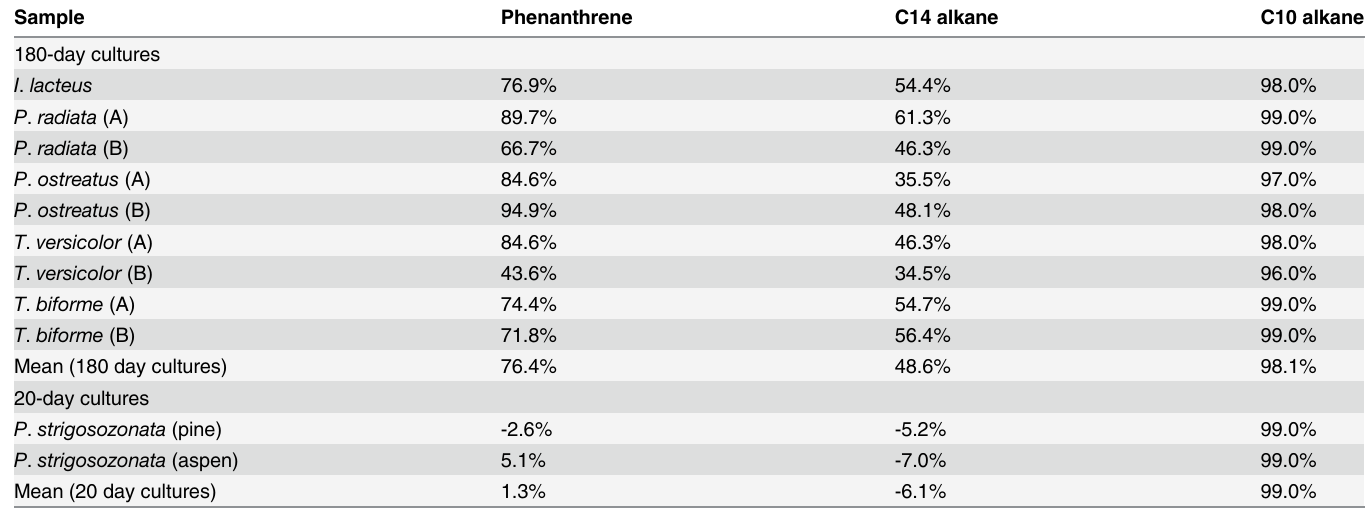
Table 1. Degradation (%) of phenanthrene, a C14 alkane, and a C10 alkane in Bunker C oil by white-rot fungi. Sample